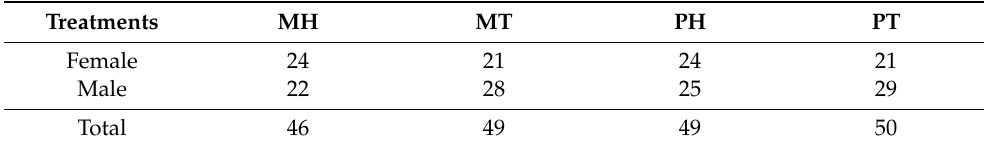
Table 1. Subject distribution by treatment and gender.